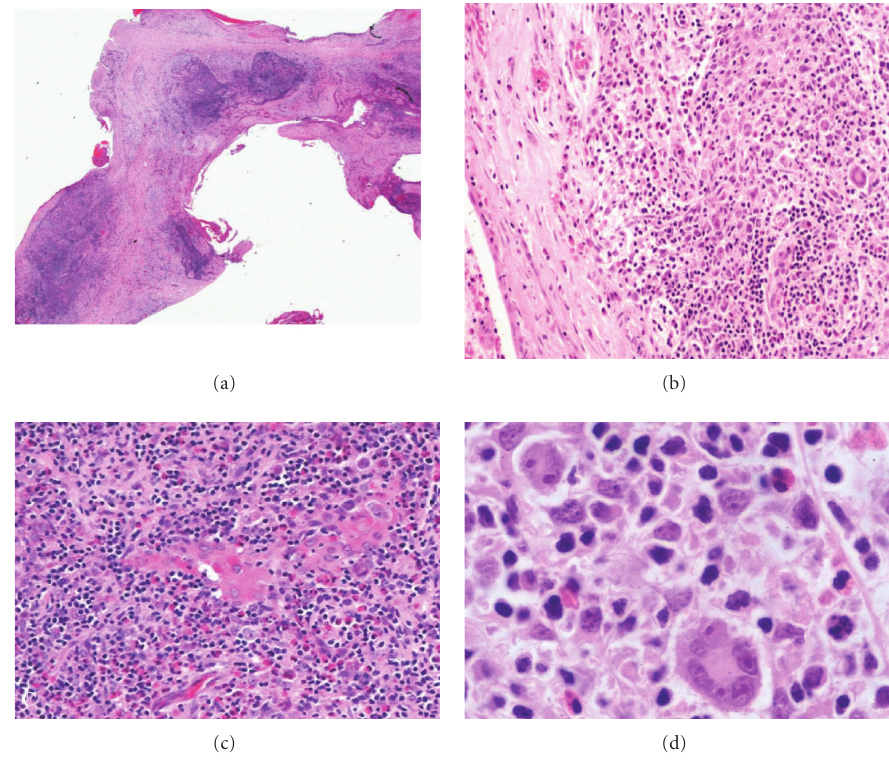
Figure 2: Hodgkin lymphoma in thymic cyst. (a) Wall of thymic cyst with nodules of cellular/inflammatory infiltrates (H&E. 25 × ). (b) Thymic cyst wall devoid of epithelium demonstrating the mixed inflammatory infiltrate in wall (H&E. 100 × ). (c) Hassel corpuscles surrounded by classic Reed-Sternberg cells in a mixed inflammatory background (H&E. 200 × ). (d) Classic Reed Sternberg cells present in a mixed inflammatory background of lymphocytes, histiocytes, and eosinophils (H&E. 400 × ).